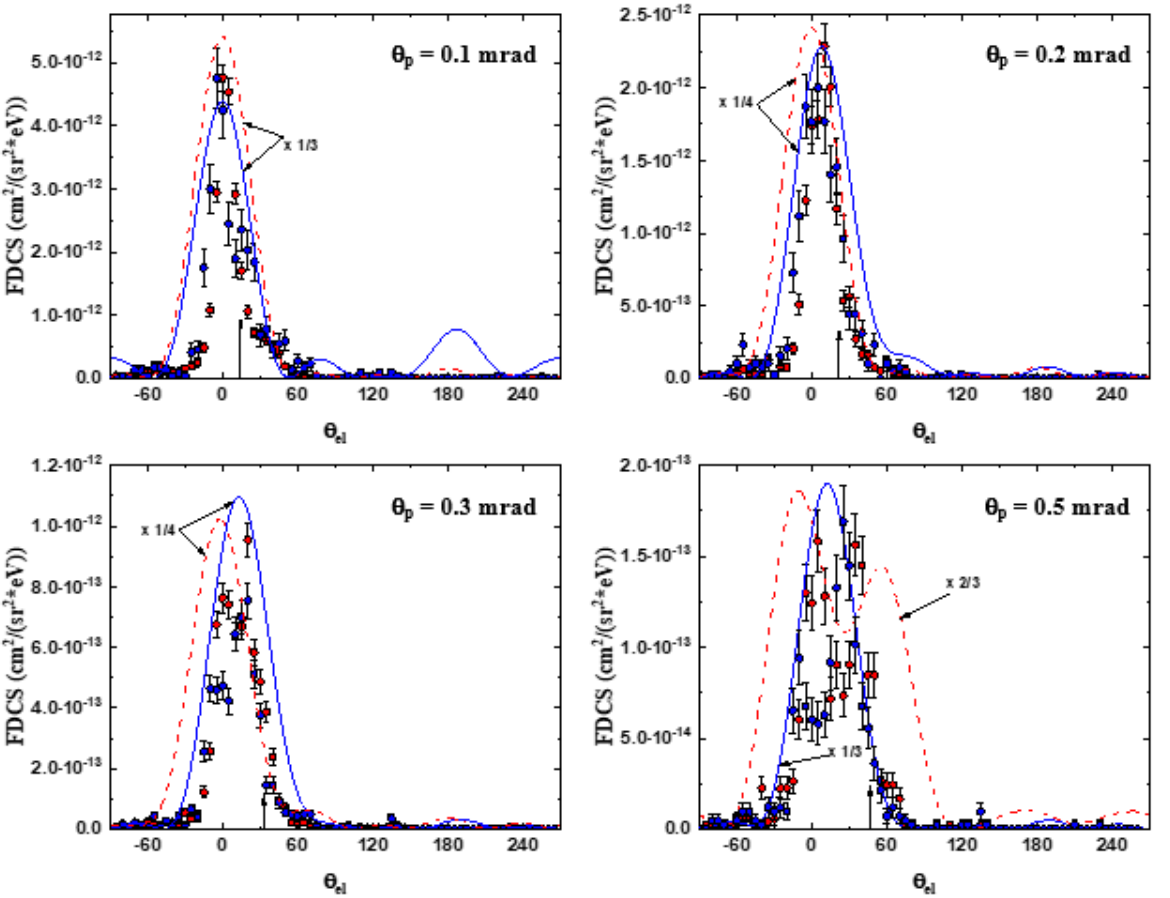
Figure 2. FDCS for electrons ejected into the scattering plane for fixed θ p as indicated in the insets as a function of θ el . Red symbols, coherent data; blue symbols, incoherent data; red dashed curves, coherent theory; blue solid curves, incoherent theory. The vertical arrows indicate the direction of q